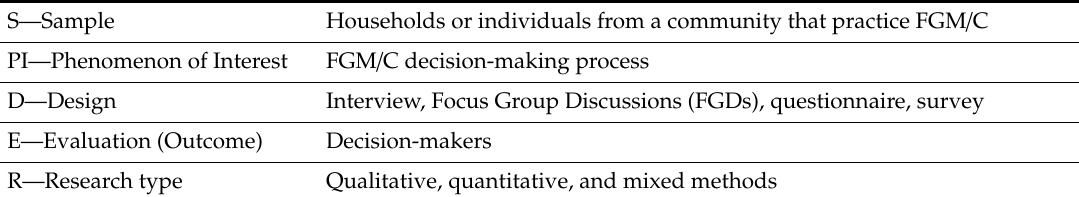
Table 1. SPIDER search